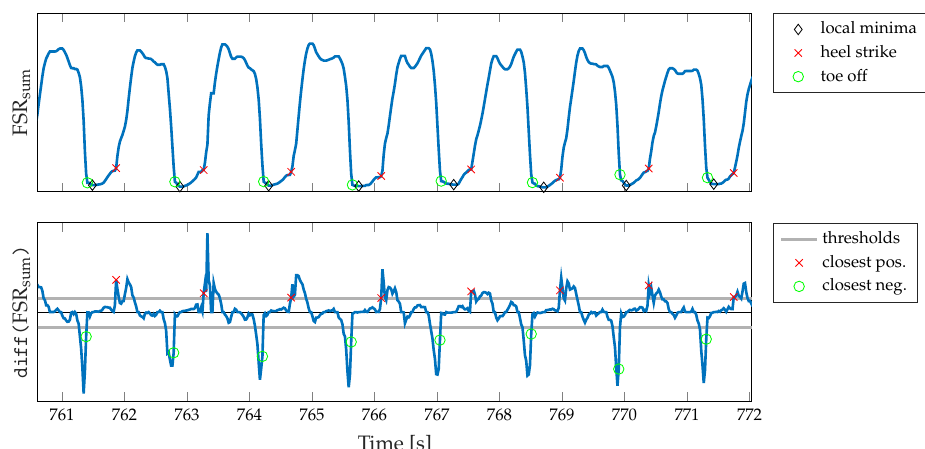
Figure 9. Exemplary illustration of the segmentation algorithm. The algorithm utilizes the summed-up FSR signal and its derivative, respectively, to identify TO and HS events during gait phases.